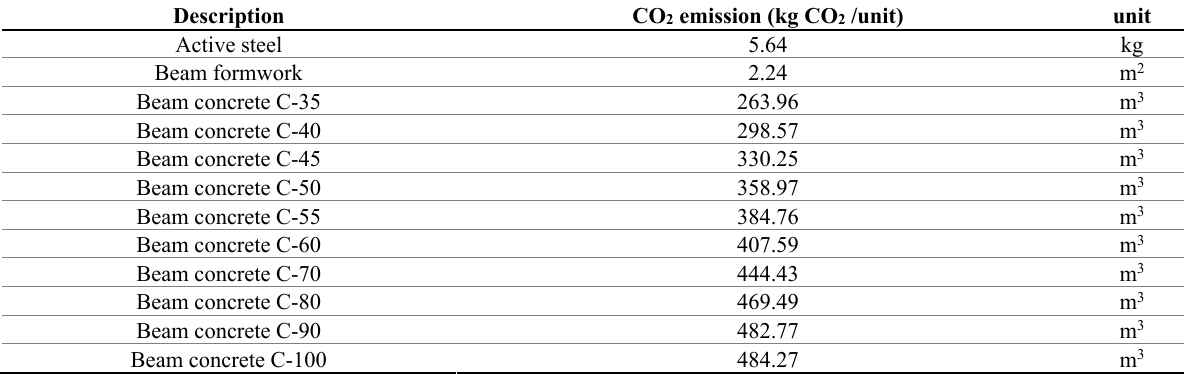
Table 8. Unit CO 2 emission of the beam in the production stage [1].